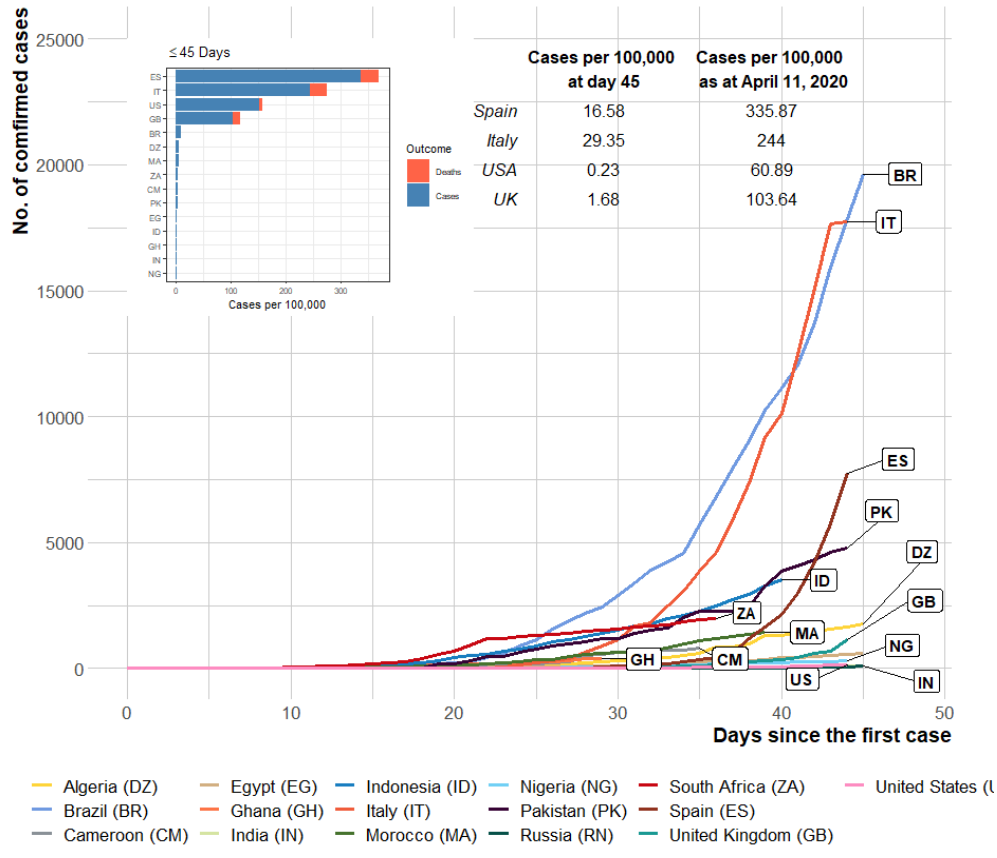
Figure 3. The number of cases in the first 45 days of COVID-19 arrival to selected countries (inside and outside Africa). Inset: bar plot showing cases per 100,000 population at day 45. Comparison of cases per 100,000 on day 45 and on 11 April 2020 (around a month later).